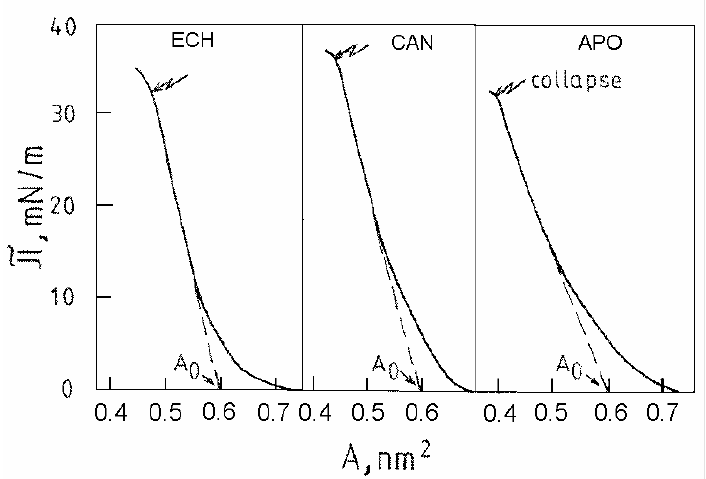
Fig. 3 Compression isotherms: surface pressure versus mean molecular area